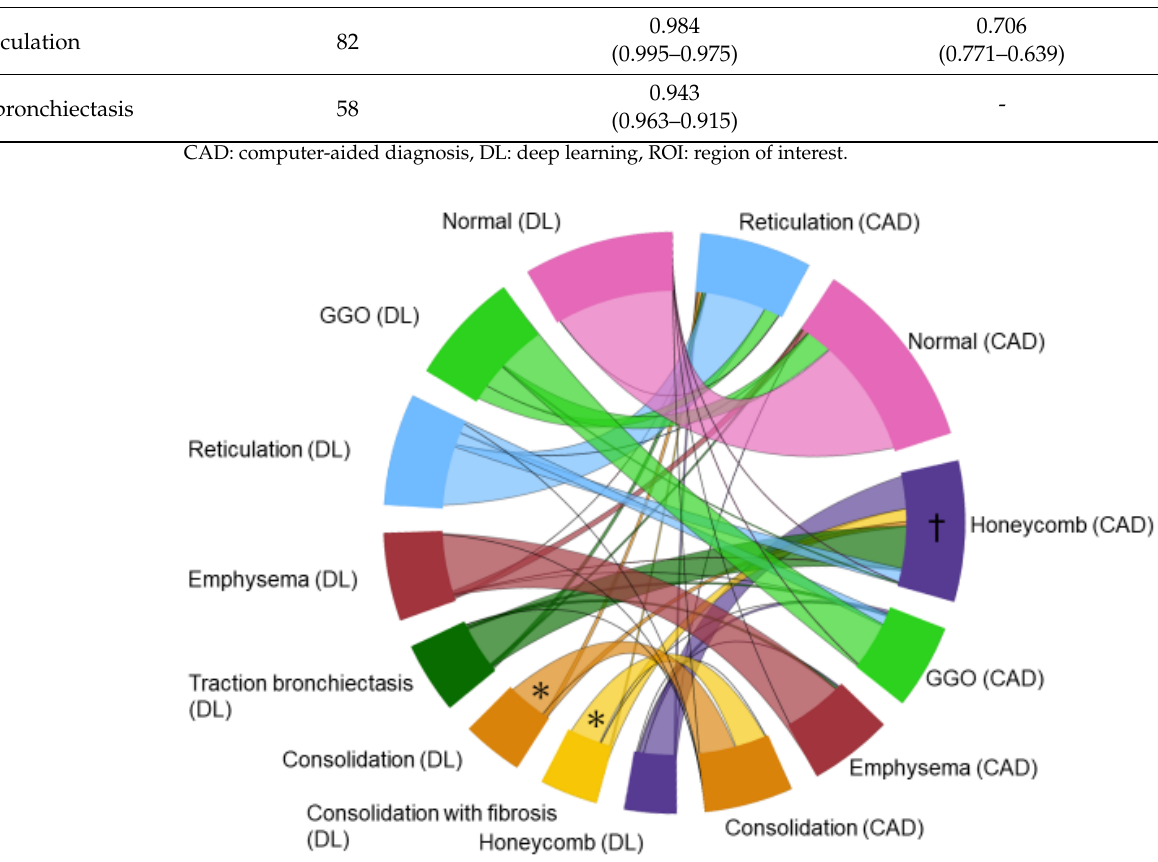
Table 5. Correlations between the DL-based analysis results and pulmonary function test results. Pulmonary Function Test